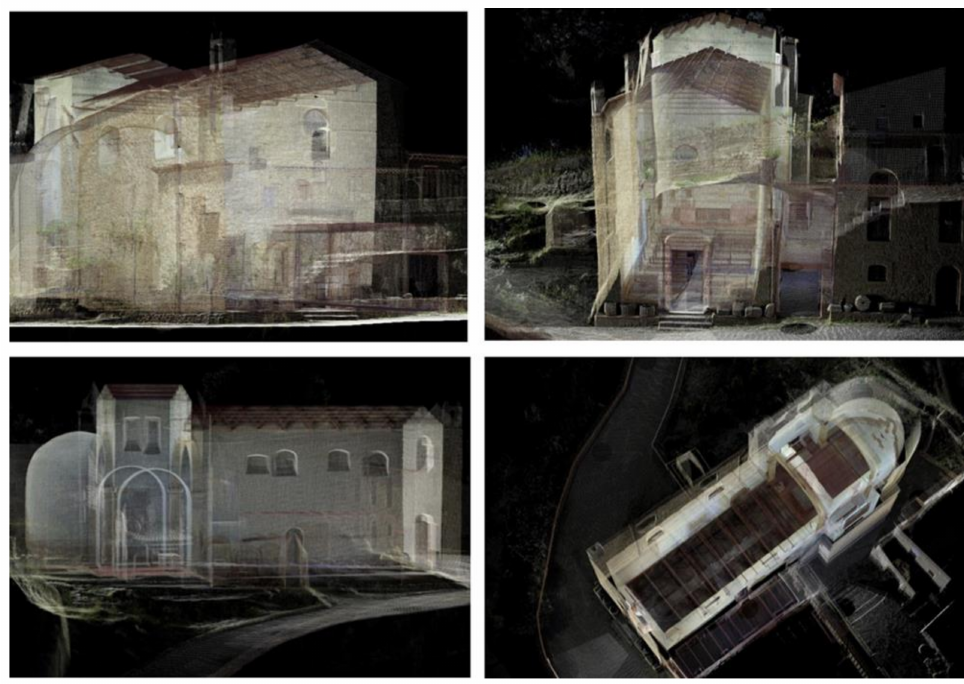
Figure 15. Different views of the three-dimensional model.